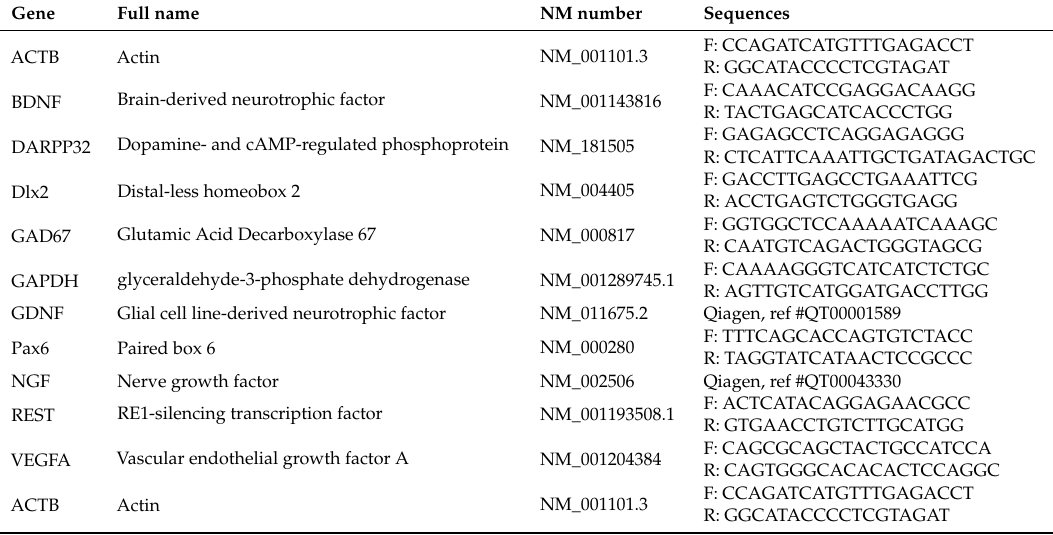
Table 1. Primer sequences used for